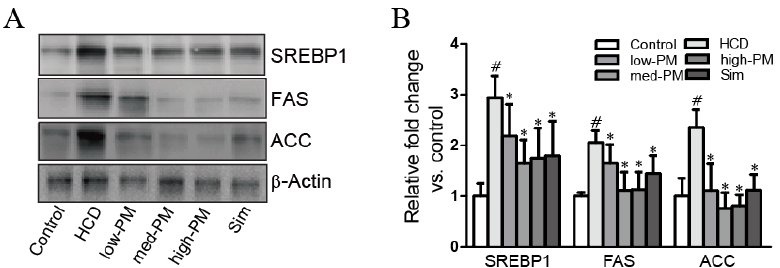
Figure 4. Effects of PM treatment on hepatic cholesterol homeostasis-related proteins in hypercholesterolemic rats. ( A ) Liver extracts from HCD diet, PM, and simvastatin treated groups were used for Western blot analysis; ( B ) Expression levels of SREBP1, FAS, and ACC were quantified by measuring band densities with National Institutes of Health (NIH) Image J software. β -actin was used as a loading control. Data are expressed as mean ± SEM. Significance was measured by performing a one-way ANOVA followed by Bonferroni’s post-hoc test. # p < 0.05 vs. control group. * p < 0.05 vs. HCD-fed group. HCD, high cholesterol diet-fed group; low-, med-, and high-PM: low (1.65 × 10 9 cfu/kg/day), medium (5.5 × 10 9 cfu/kg/day), and high doses (1.65 × 10 10